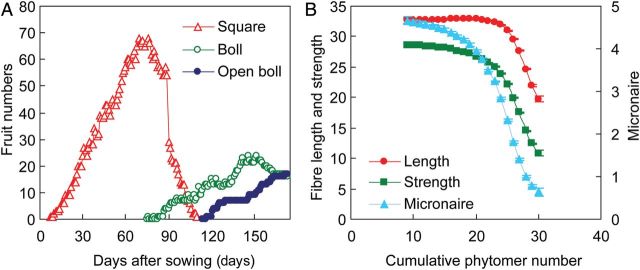
Simulated dynamic course of fruit numbers (squares, bolls and open bolls) (A) and final cotton fibre length (mm), strength (cN tex−1) and micronaire against CPN (phytomer position counted from the bottom of the plant) (B) at 210 simulated days after sowing (n = 10, error bars show 2 × SE). The model was run for monoculture of cotton with MC application at a plant population density of 3.6 plants m−2, and main shoot and branch topping applied at 30 July and 30 August, respectively, to terminate further appearance of new phytomers.